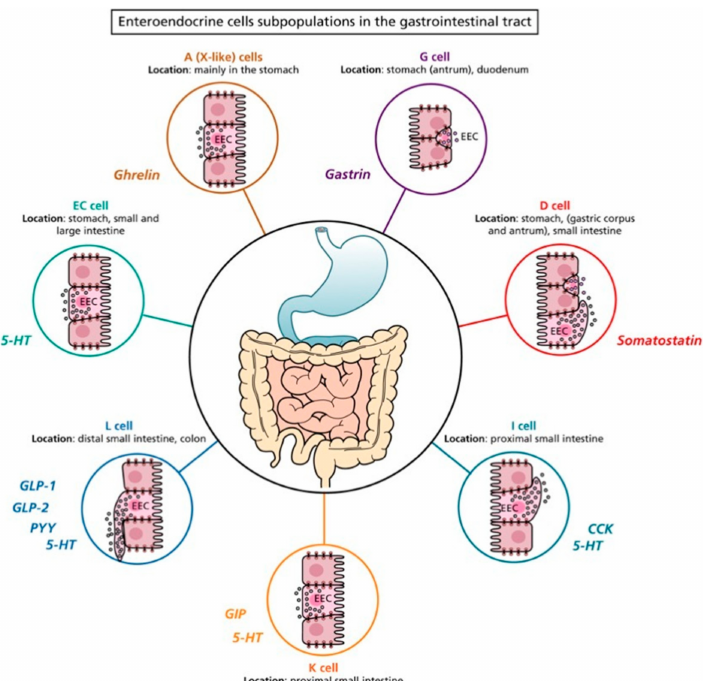
Figure 3. Schematic representation of the enteroendocrine cell subpopulation in the gastrointestinal (GI) tract. EC: enterochromaffin cell; 5-HT: 5-hydroxytryptamine; CCK: cholecystokinin; GLP-1: glucagon like peptide-1; GLP-2: glucagon like peptide-2; PYY: peptide YY; GIP: gastric inhibitory peptide-1; dark red circle indicates the A cells secreting ghrelin in the stomach (corpus); purple circle indicates the G cells secreting gastrin in the stomach (antrum); red circle indicates the D cells secreting somatostatin in the stomach (pylorum); dark blue circle indicates the I cells and orange circle indicates the K cells secreting CPK and GIP in the small intestine; light blue circle indicates the L cells secreting GLP-1, GLP-2 and PYY, widely distributed in small intestine and in colon. The Figure is obtained from Latorre et al., 2016. Reprinted under the terms of the Creative Commons CC BY license [8]. Table 1. Enteroendocrine cells (EECs) and their secreted products in the gastrointestinal (GI) tract. (5-HT: 5-hydroxytryptamine; CCK: cholecystokinin; GLP-1: glucagon like peptide-1; GLP-2: